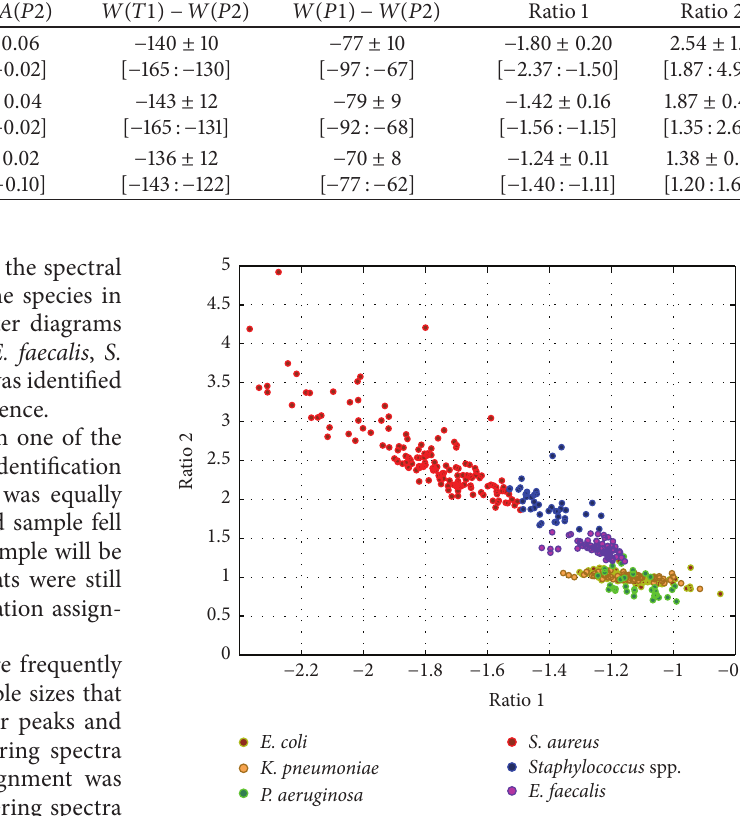
Figure 2: Scatter plot of Ratio 2 versus Ratio 1 characteristics of multiwavelength angular scattering spectra of target species training